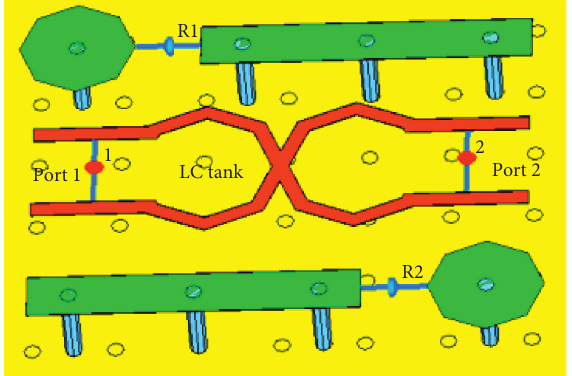
Figure 2: Excitation of packaging